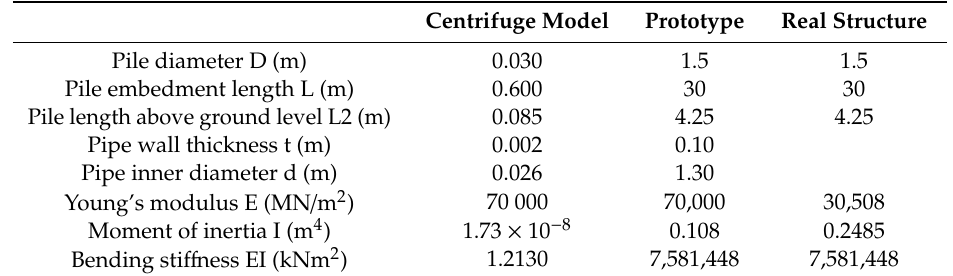
Table 1. Centrifuge model dimensions (after Kotthaus [50]). Prototype model mimic the real concrete pile, with the concrete class between C20 / 25 and C25 /